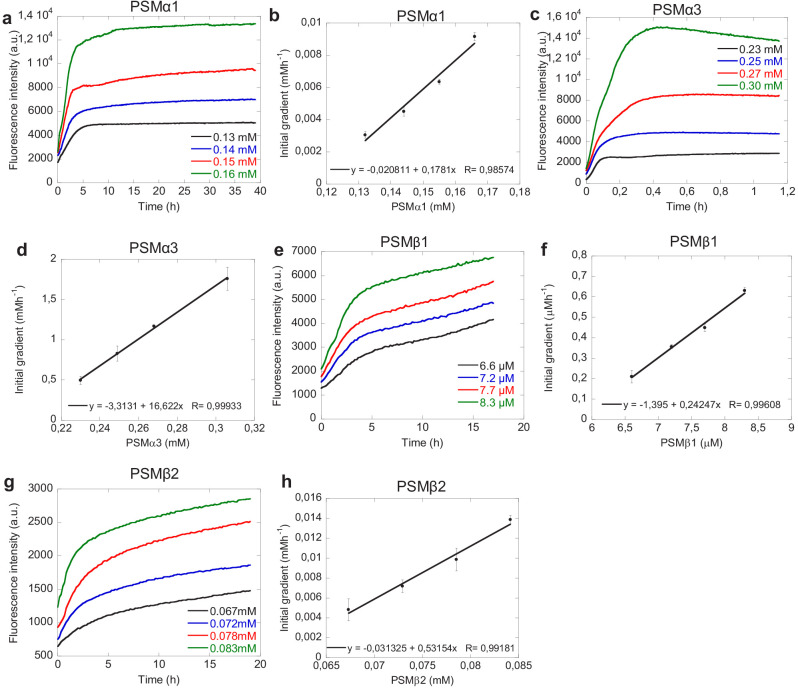
Seeding with high amounts of seeds.Seeding of phenol-soluble modulin (PSM) peptides with 20–50% preformed fibrils seeds (in monomeric equivalents) at different monomeric concentration. (a) Changes in ThT fluorescence when monomeric PSMα1 at fixed concentration (0.25 mg/mL) was incubated in the presence of high concentrations of preformed fibrils from the PSMα1 under quiescent conditions at 37°C. (b) Initial gradient of the ThT fluorescence curves of PSMα1 used to estimate the elongation rates. The initial gradient (first 120 min) is plotted against the free monomer concentration. A straight line was fitted to these points, with the slope proportional to the number of seed fibrils and the elongation rate constant. (c) Changes in ThT fluorescence when monomeric PSMα3 at fixed concentration (0.5 mg/mL) was incubated in the presence of high concentrations of preformed fibrils from the PSMα3 under quiescent conditions at 37°C. (d) Initial gradient of the ThT fluorescence curves of PSMα3 used to estimate the elongation rates. The initial gradient (first 2 min) is plotted against the free monomer concentration. A straight line was fitted to these points, with the slope proportional to the number of seed fibrils and the elongation rate constant. (e) Changes in ThT fluorescence when monomeric PSMβ1 at fixed concentration (0.025 mg/mL) was incubated in the presence of high concentrations of preformed fibrils from the PSMβ1 under quiescent conditions at 37°C. (f) Initial gradient of the ThT fluorescence curves of PSMβ1 used to estimate the elongation rates. The initial gradient (first 120 min) is plotted against the free monomer concentration. A straight line was fitted to these points, with the slope proportional to the number of seed fibrils and the elongation rate constant. (g) Changes in ThT fluorescence when monomeric PSMβ2 at fixed concentration (0.25 mg/mL) was incubated in the presence of high concentrations of preformed fibrils and the PSMβ2 under quiescent conditions at 37°C. (h) Initial gradient of the ThT fluorescence curves of PSMβ2 used to estimate the elongation rates. The initial gradient (first 120 min) is plotted against the free monomer concentration. A straight line was fitted to these points, with the slope proportional to the number of seed fibrils and the elongation rate constant.
Figure 1—figure supplement 4—source data 1.Seeding with high amounts of seeds for determination of elongation rates.